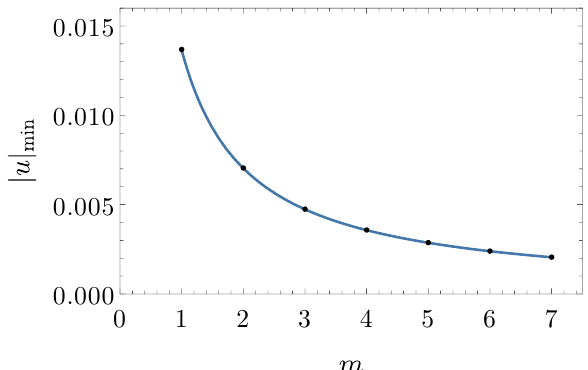
Figure 3 . Deviation of the minimum of V m, 0 ( τ, ¯ τ ) from the left cusp τ = ω measured by | u | = | ( τ − ω ) / ( τ − ω 2 ) | . Values obtained numerically (black dots) match the analytical approximation of eq. (3.3) (blue